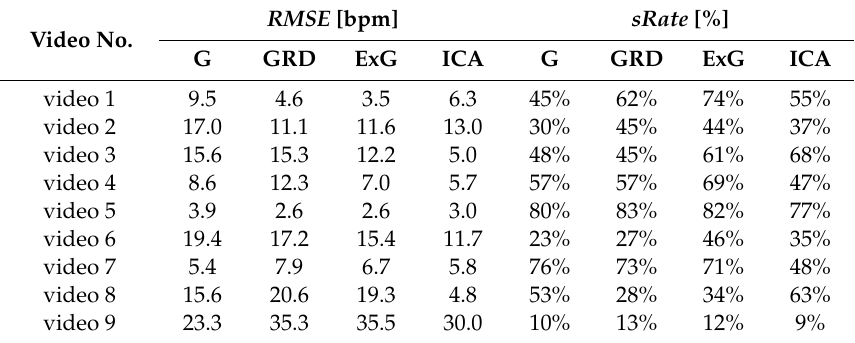
Table A5. Results of HR estimation, algorithm No. 3 (TIME)—comparison of signal extraction methods. Video